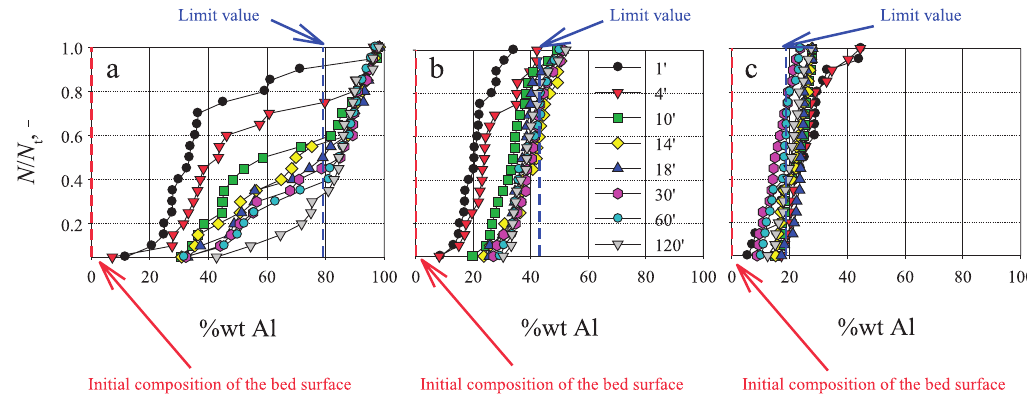
Fig. 9 Cumulative distribution of aggregate composition at different times for Al 2 O 3 and Fe 2 O 3 mixing tests. (a) A mixing test; (b) B mixing test; and (c) C mixing test.